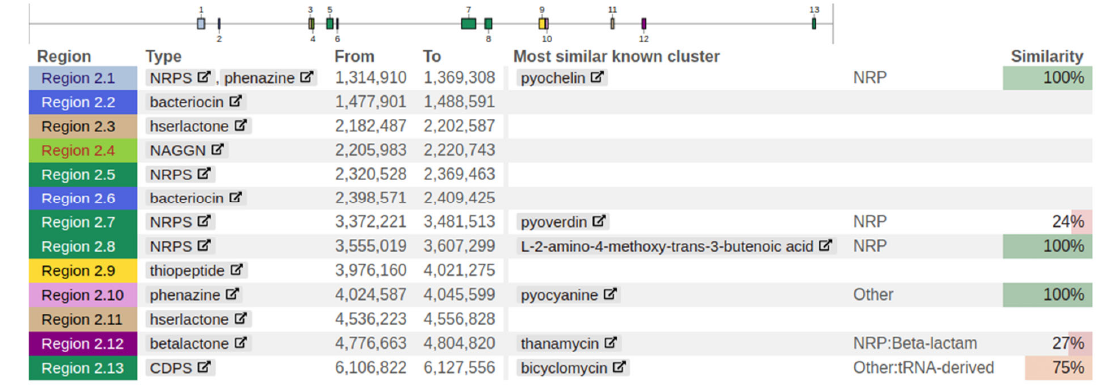
Figure 9. Location of secondary metabolite biosynthesis gene clusters in the FG106 genome.